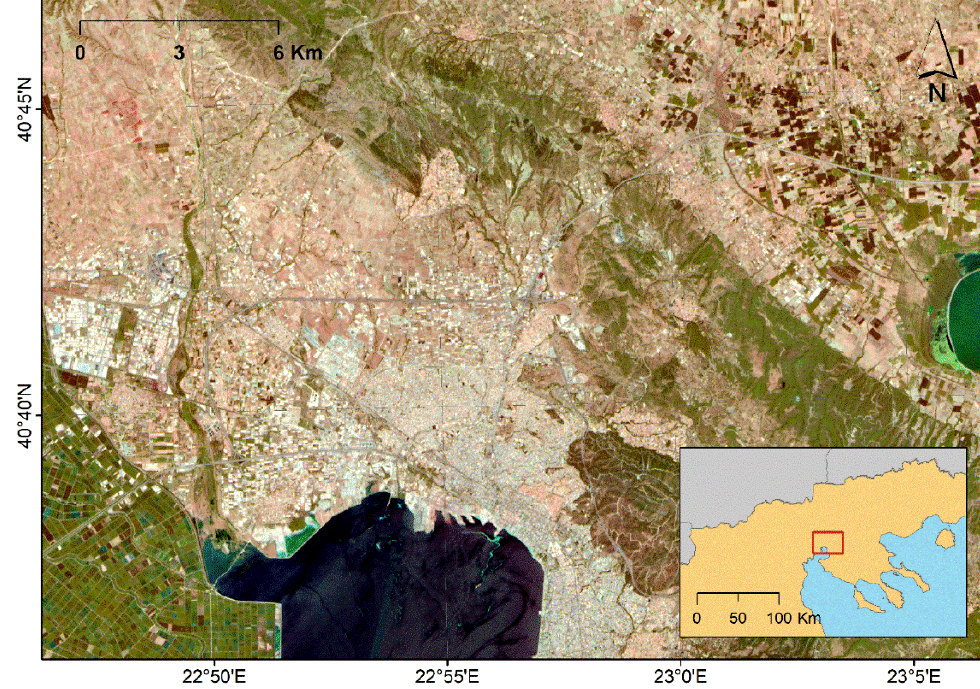
Figure 1. The Sentinel-2 image subset covering the study area (28 June 2017) (false-color RGB com- posite: bands 10-4-3); in the inset, the location map. composite: bands 10-4-3); in the inset, the location